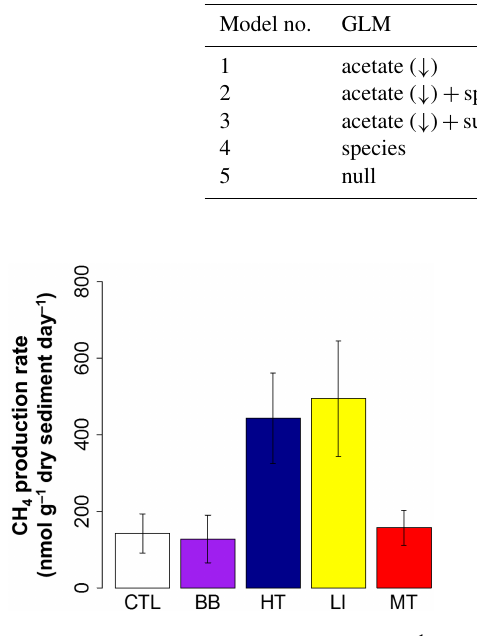
Figure 5. Mean CH 4 production rates (nmolg − 1 dry sedi- mentday − 1 ) from organic matter treatments (CTL is control, BB is buckbean Menyanthes trifoliata , HT is horsetail Equisetum variega- tum , LI is lily Nuphar polysepalum , and MT is marestail Hippuris vulgaris ) replicated in five non-tidal freshwater wetlands during Au- gust 2014. Error bars represent standard error.